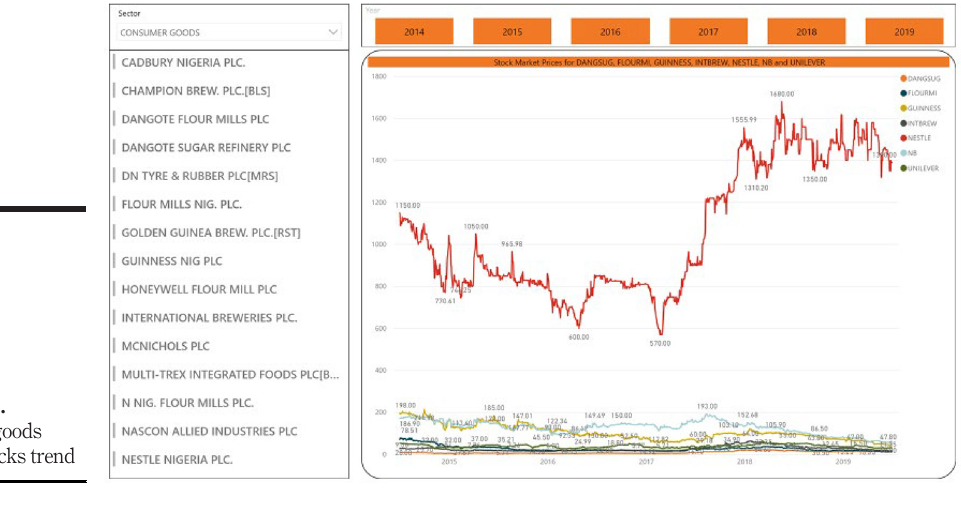
Figure A3. Consumer goods selected stocks trend